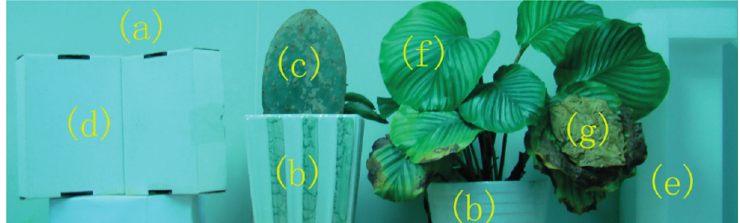
Figure 2. Scene employed for the MSL system scanning experiment. From ( a ) to ( g ) were white wall, ceramic pots, Cactaceae , carton, plastic foam block, and healthy and dead leaves of E. aureum ,